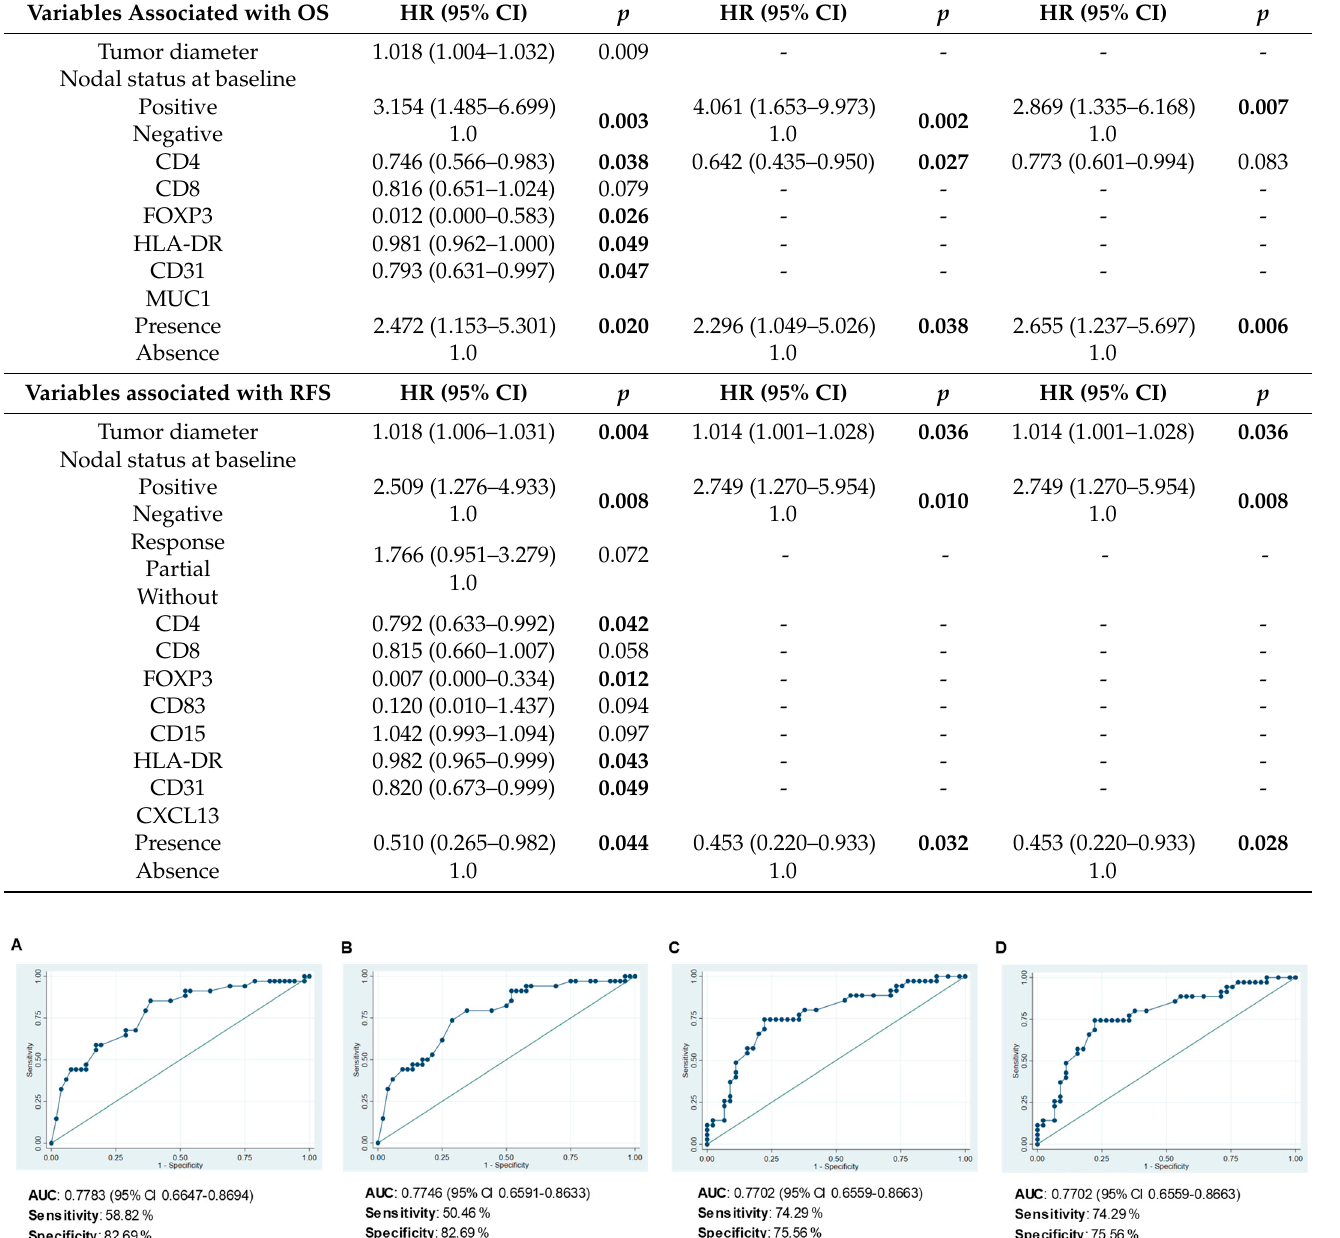
Multivariate Analysis after Bootstraping